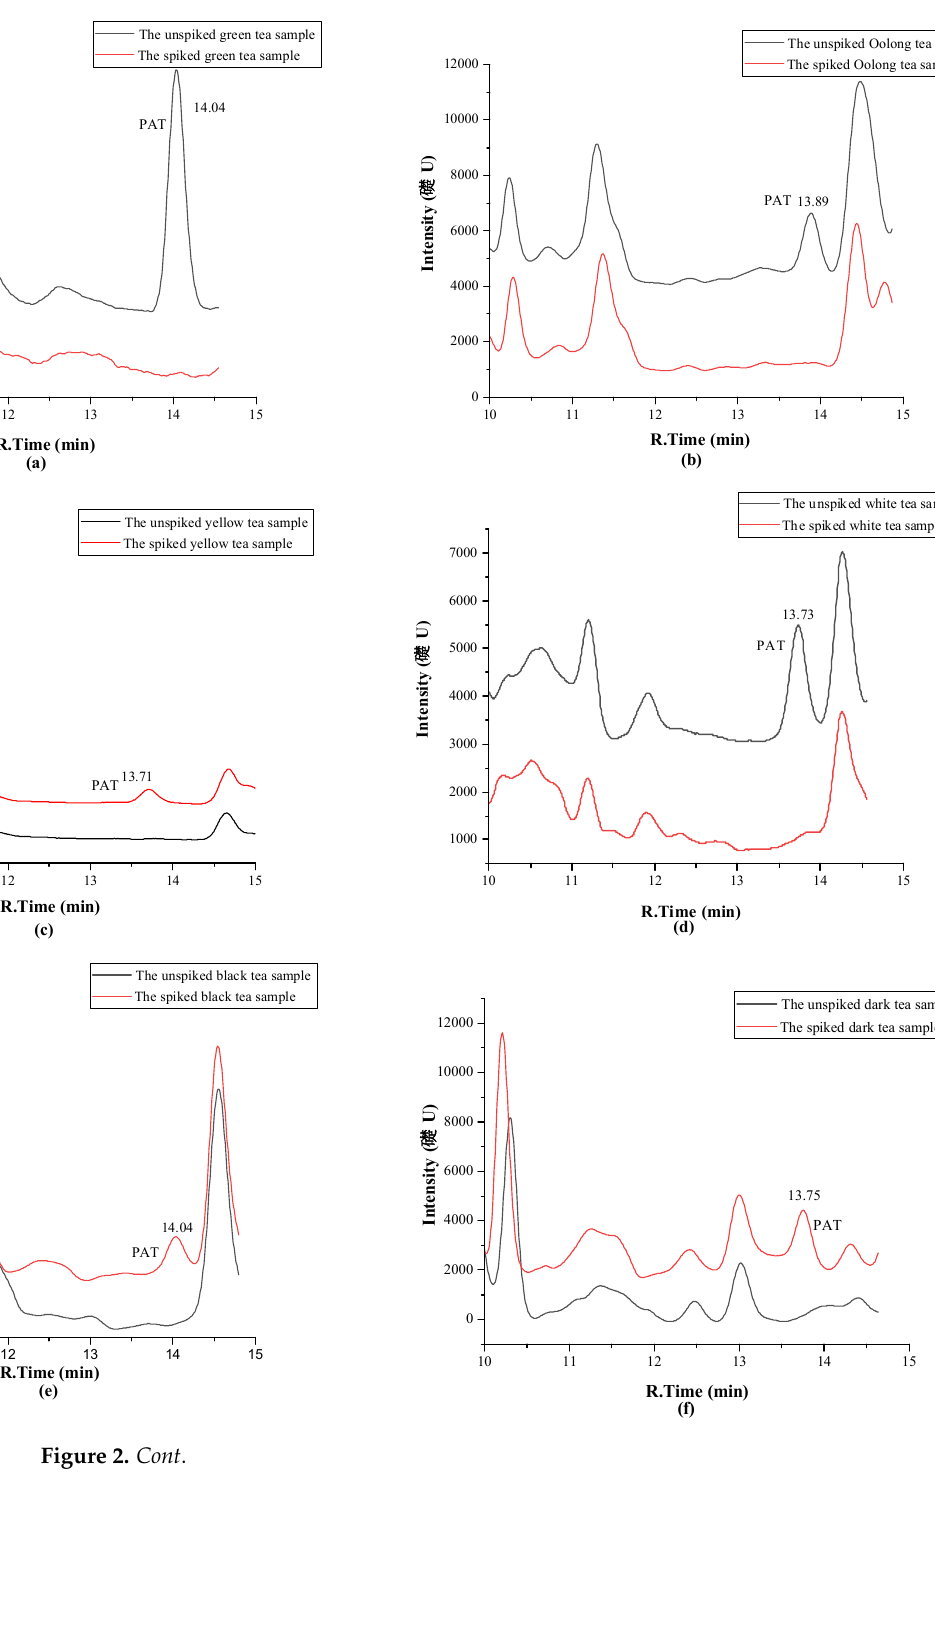
Figure 2a–h. Chromatograms and DAD−UV spectra of PAT standard (50 ng/mL) and a black tea sample naturally contaminated with PAT (43.4 ng/g) are shown in in Figure 3a,b. Again, a PAT concentration of 50 ng/g in tea is well below the PAT content of 1 μg/g that constitutes a health risk for heavy tea drinkers.